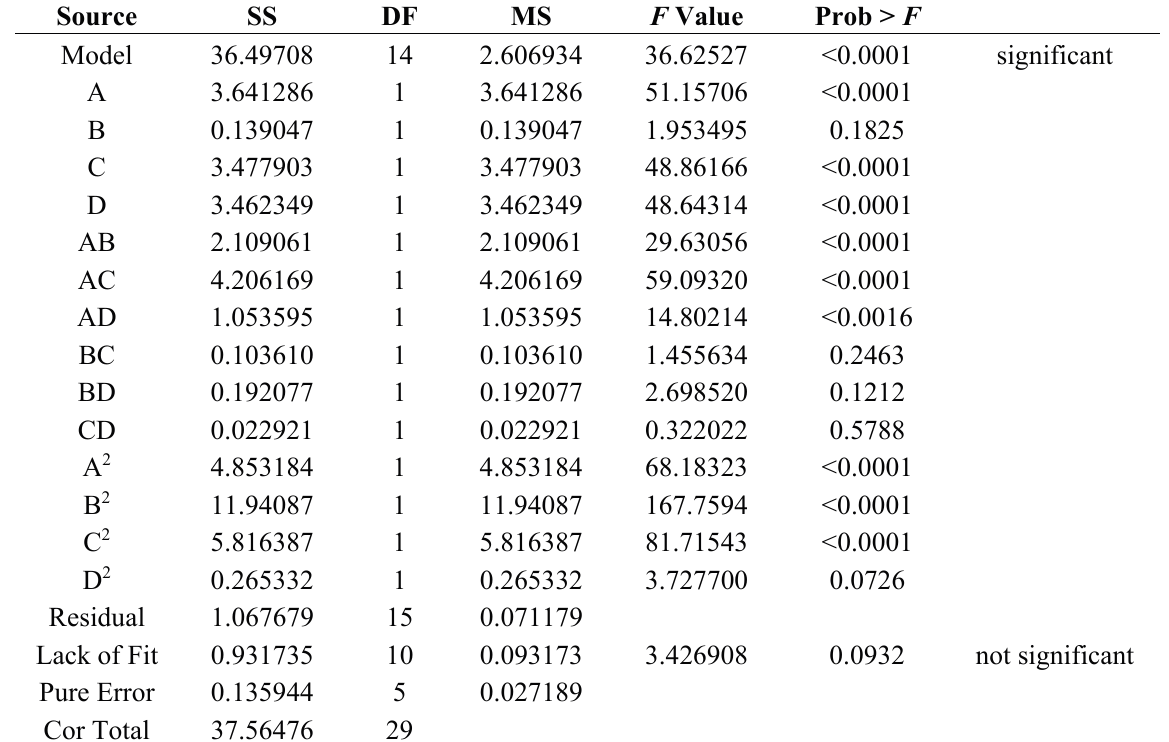
Table 2. Analysis of variance (ANOVA) for the